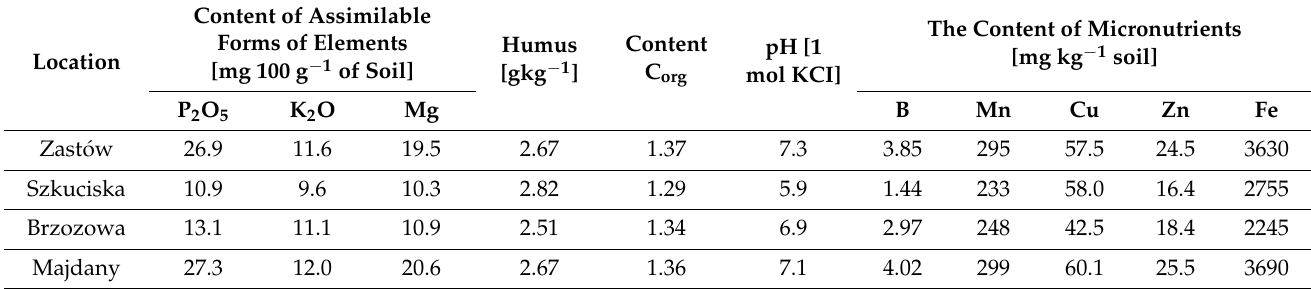
Table 6. Content of available forms of P 2 O 5 , K 2 O, Mg, B, Mn, Cu, Zn, Fe, humus, C org in the soil and soil acidity (Mean 2015–2017). Content of Location